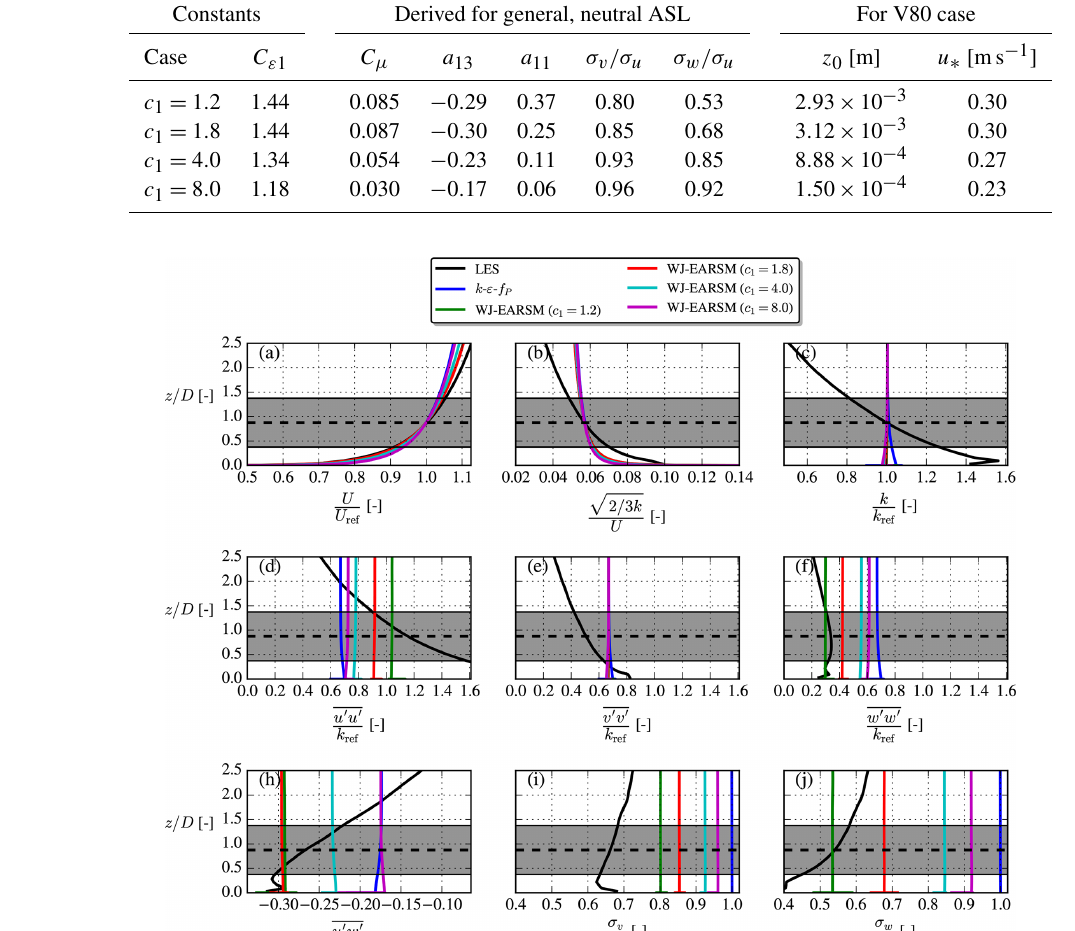
which is close to the value used by WAsP CFD (Bechmann, 2016); and finally the last set ( c 1 = 8 . 0) gives C µ = 0 . 03, which is often used for atmospheric applications (Sørensen, 1995; Richards and Hoxey,